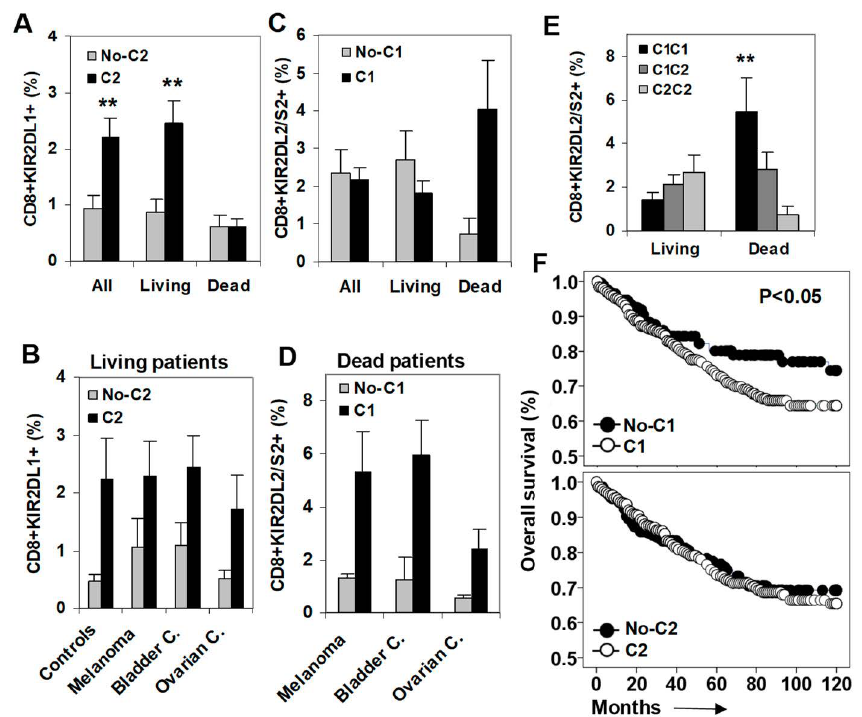
Figure 2. Impact of C2- and C1-ligands on the frequency of KIR2DL1 + and KIR2DL2 / S2 + CD8 + T cell subsets and on patient survival. ( A ) Frequency of KIR2DL1 + CD8 + T cells (% of total lymphocytes) in all patients ( n = 249), patients who survived (Living, n = 208), and patients who died during the follow-up (Dead, n = 41) according to the presence of the specific C2-ligand. ** p < 0.01. ( B ) Frequency of KIR2DL1 + CD8 + T cells in healthy controls and in living melanoma, bladder, and ovarian cancer patients. ( C ) Frequency of KIR2DL2 / S2 + CD8 + T cells in all, living, and dead patients according to the presence of their specific C1-ligand. ( D ) Frequency of KIR2DL2 / S2 + CD8 + T cells in dead melanoma, bladder, and ovarian cancer patients. ( E ) Frequency of KIR2DL2 / S2 + CD8 + T cells in living and dead cancer patients according to the dose of its specific C1-ligands. ( F ) Kaplan-Meier and Log-rank tests for overall survival (OS) of solid cancer patients ( n = 248) according to the presence of C1- and C2-ligands.